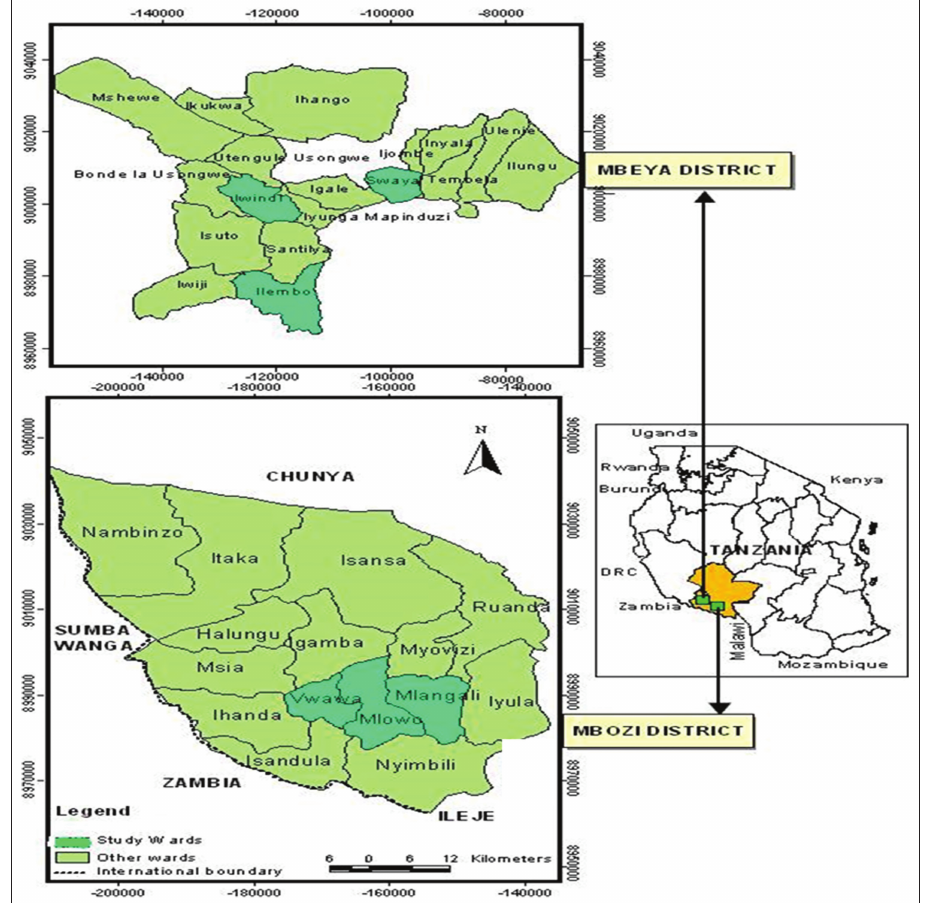
Figure-1: A map showing the study area in Mbeya region,